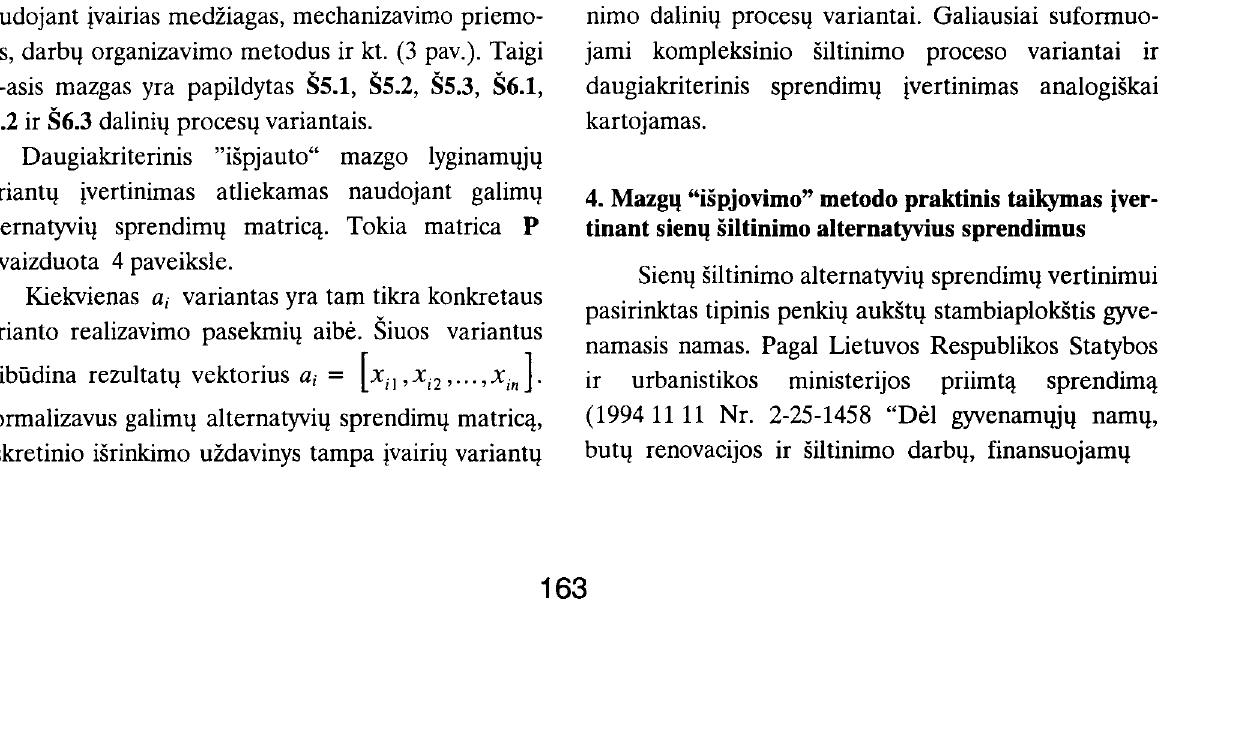
Fig 4. Matrix P of possible alternative decisions